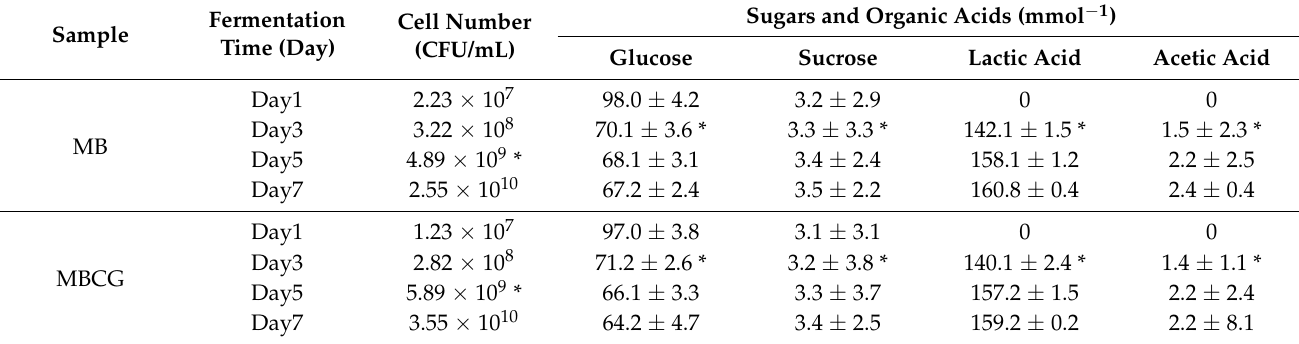
Table 1. Changes in the concentrations of the sugars and organic acids in the MRS Broth (MB) and MRS Broth with crushed garlic (MBCG) during fermentation at 30 ◦